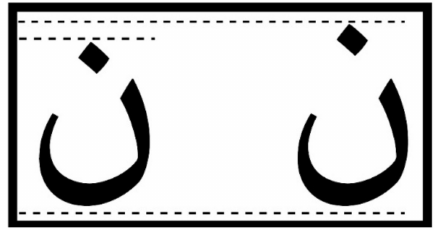
Figure 3. Vertical point shifting (Adapted from